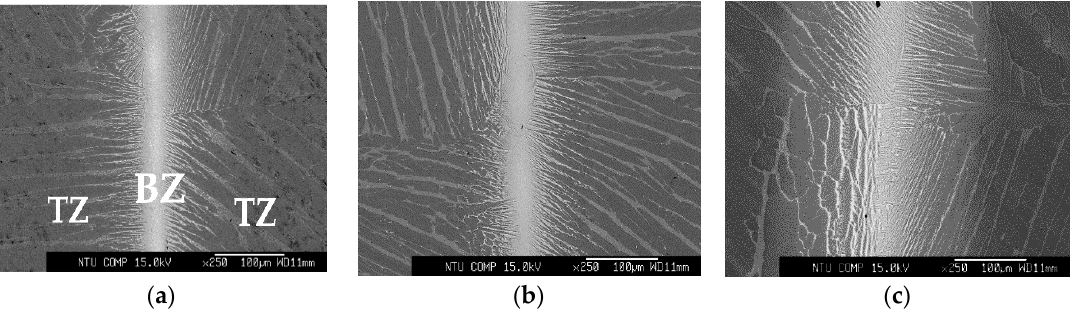
Figure 2. Electron probe microanalyzer (EPMA) backscattered electron images (BEIs) of CP-Ti/40Ti- 35Ni-25Nb/CP-Ti joints brazed at ( a ) 1000, ( b ) 1100 and ( c ), 1200 °C for 600 s.